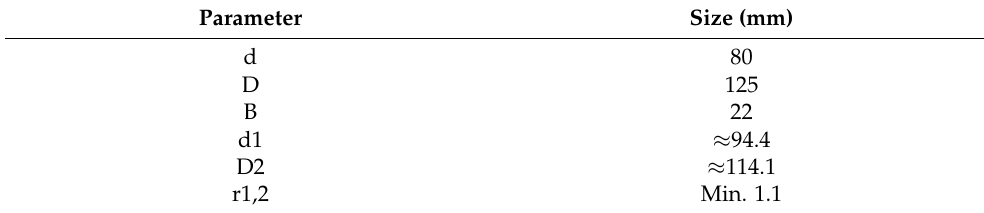
Table 7. Dataset B: Experiment bearing operation states.